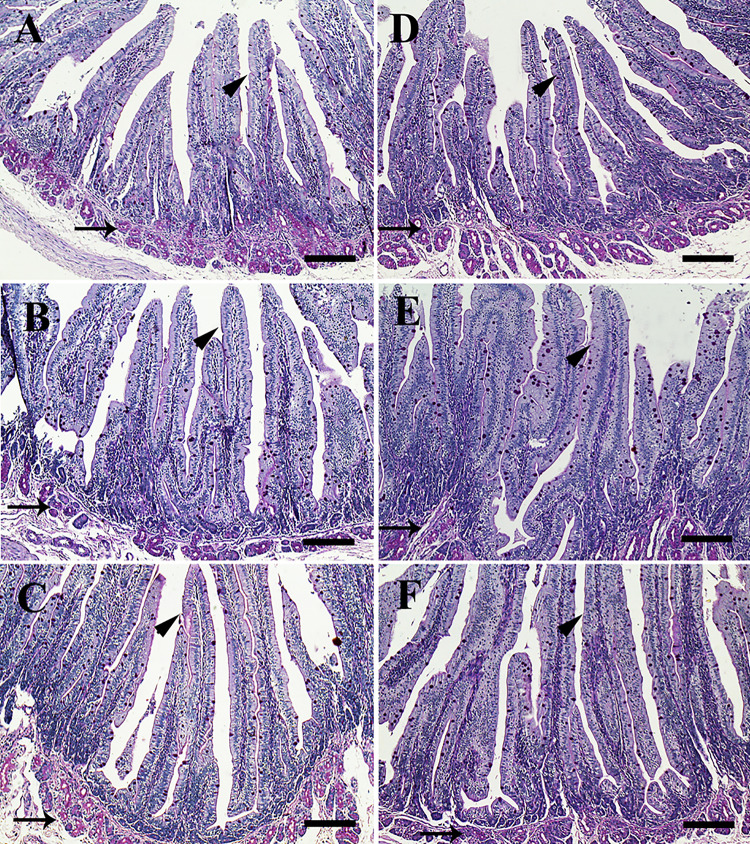
Light micrographs of duodenum revealing the effect of different doses of β glucan; control, 0.25 g β glucan (βG0.25), 0.5 g β glucan (βG0.5) on the two rabbit species; New Zealand White (NZW) and APRI rabbits were represented in (A to C) and from (D to F), respectively. The micrographs showing the increasing in the villi height (VH) from (A to C) and from (D to F). Villi (arrowheads), Brunner’s gland (arrows). PAS stain. Scale bar is 400 μm.